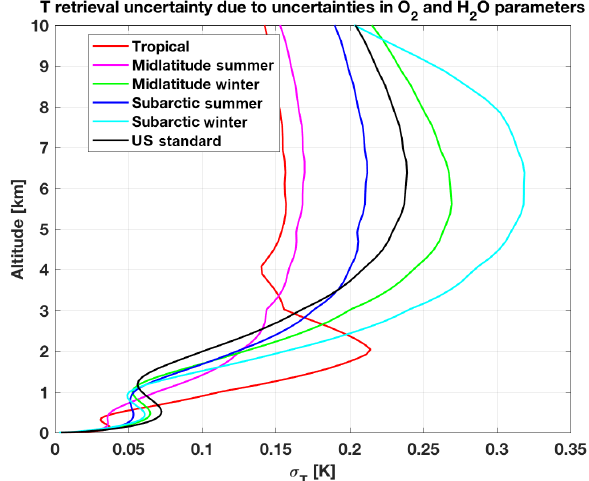
Figure 11. As in Fig. 11, but for specific humidity retrievals. Data availability. Uncertainty covariance matrices for the spectro- scopic parameters considered here, as well as the resulting T B un- certainty covariance matrices for HATPRO and MP3000A chan- nels, are available as a Supplement to this paper. The absorption model by Rosenkranz (2017) is available as a FORTRAN 77 code at https://doi.org/10.21982/M81013 (Rosenkranz, 2017). Older ver- sions, including the one used here (15 May 2017), are available at http://cetemps.aquila.infn.it/mwrnet/lblmrt_ns.html (last access: 23 October